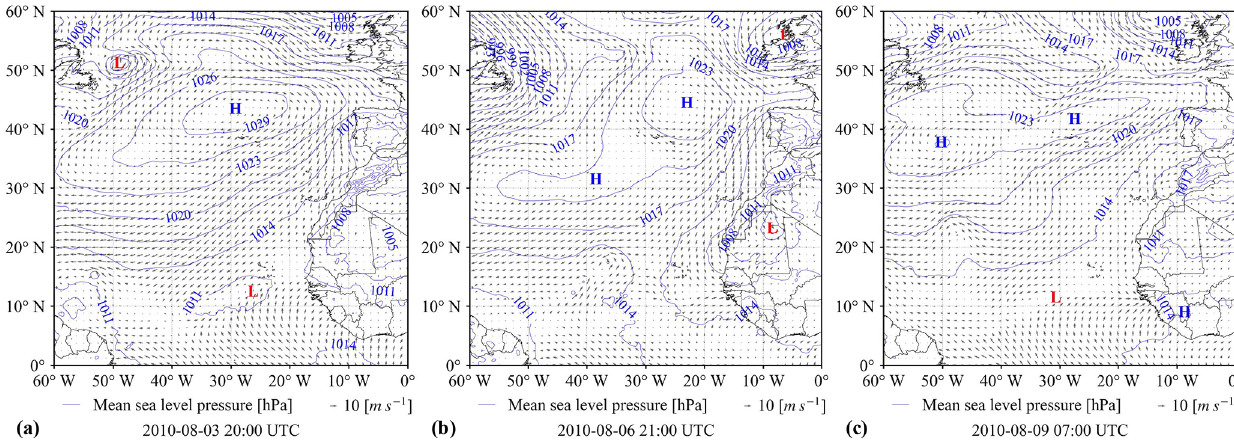
Figure 7. Synoptic-flow conditions including mean sea level pressure and 10m winds from the ERA5 reanalysis at the (a) starting, (b) middle and (c) ending time of the case study period. A wind velocity of 10ms − 1 is shown for reference. H ( L ) represents high-pressure (low- pressure) systems. The geographic map is from Natural